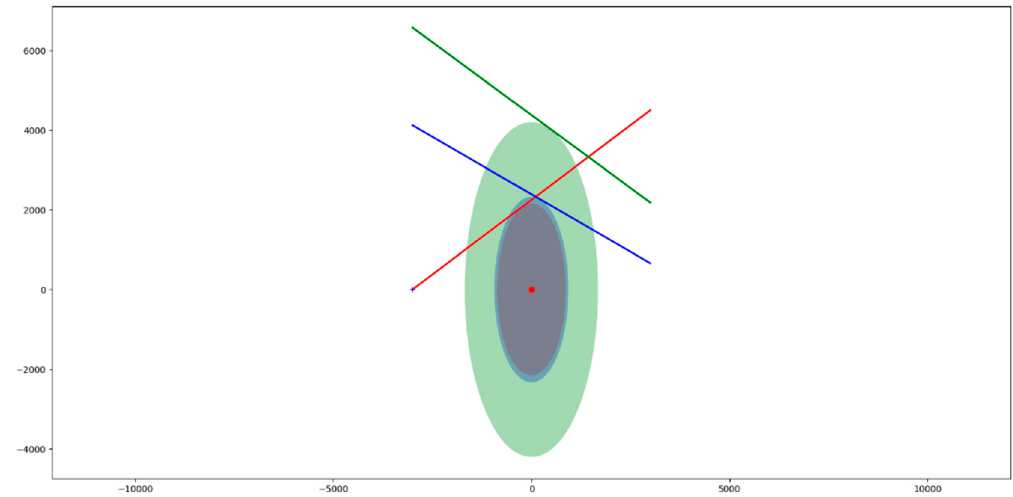
Figure 10. Intrusive relationship between the relative motion line of other ships and own ship.